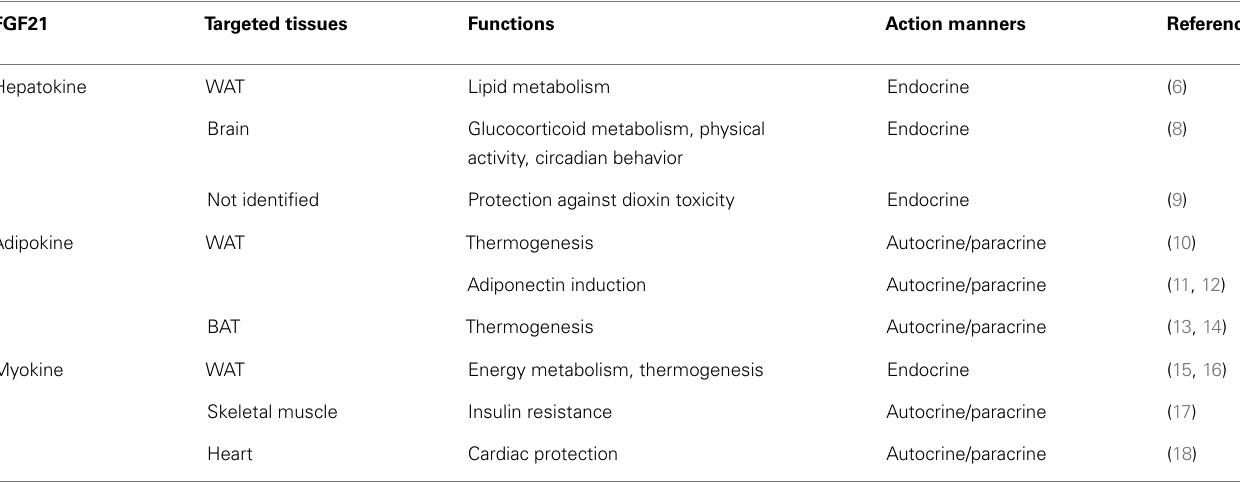
Table 1 | Functions of FGF21 as a hepatokine, adipokine, and myokine